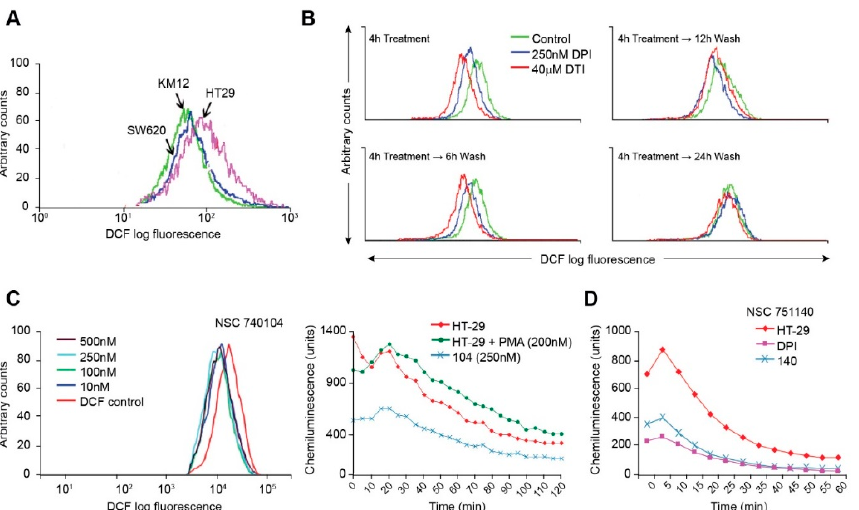
Figure 2. Inhibition of ROS production by iodonium analogs. Baseline ROS production for HT-29, KM-12, and SW620 human colon cancer cell lines is shown in ( A ) and the effects of DPI and DTI on ROS formation and recovery from treatment following removal of the drugs is demonstrated in ( B ). The effects of NSC 740104 on ROS formation in HT-29 cells are shown in ( C ). The left panel in section ( C ) demonstrates the concentration-dependent effects of NSC 740104 on ROS formation in HT-29 cells evaluated by DCF fluorescence. In the right panel the effect PMA on ROS production from NOX1 in HT-29 cells is shown as well as the inhibition of baseline ROS production in HT-29 cells by NSC740104 using an orthogonal luminescence technique to measure superoxide. The effects of NSC751140 and DPI on superoxide production determined by luminescence in HT-29 cells is demonstrated in ( D ). These results are representative of at least three